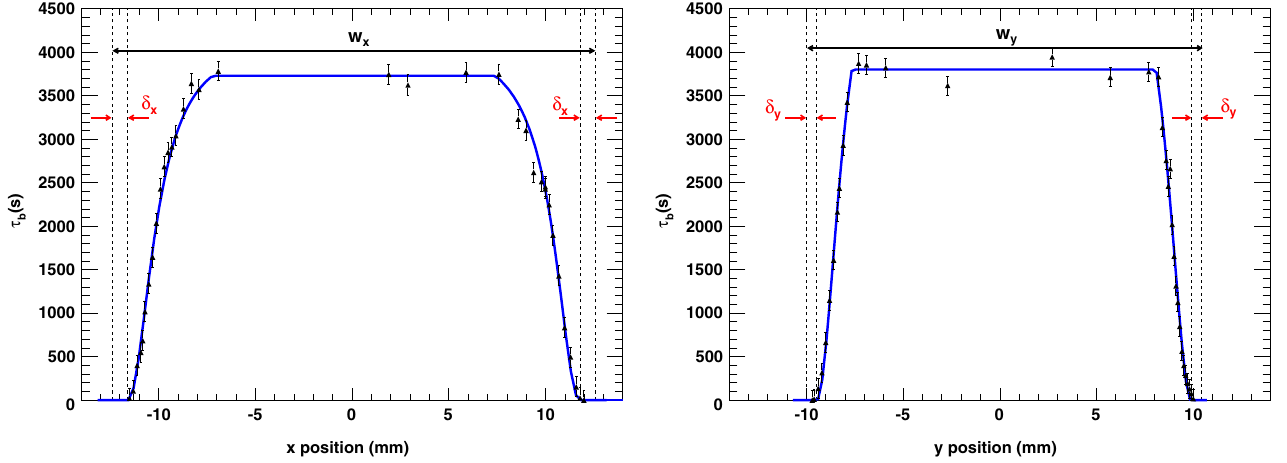
FIG. 20. Recorded beam lifetime as a function of the horizontal ( x , left panel) and vertical ( y , right) position of frame 1 (PAX target ð x Þ using (31). The fits indicate that the observed widths at the base ( τ center), and fit of τ b frame widths ( w , w ), where the discrepancies δ x y